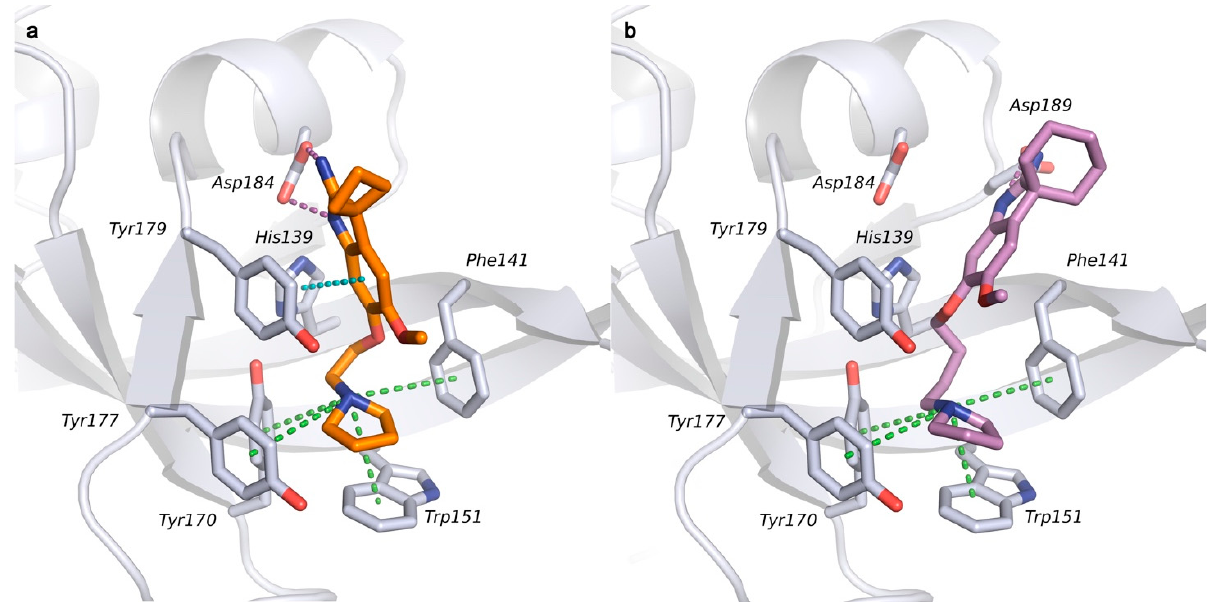
Figure 3. Docking poses of 1e ( a ) and 1c ( b ) in the Spindlin1 second domain (PDB ID: 6I8Y). Docking poses and side chains of the surrounding residues are shown as sticks. Binding interactions are represented with dashed lines colored in green (cation–pi), cyan (pi–pi stacking), and magenta (salt bridge).